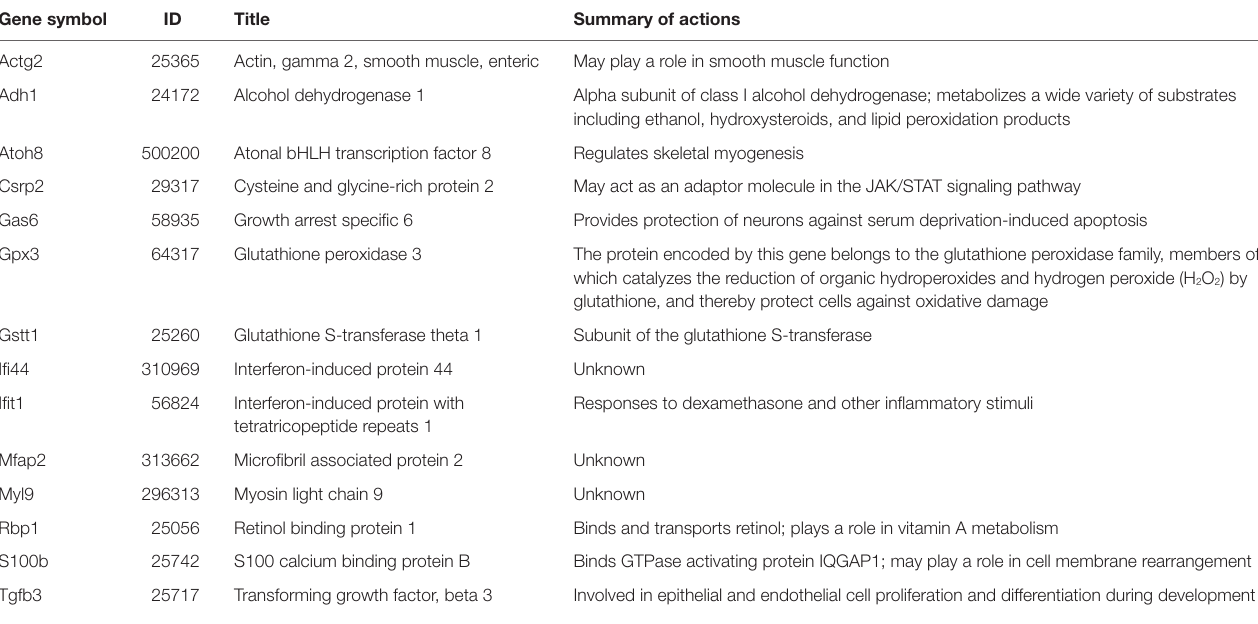
TaBle 2 | Actions of genes significantly regulated by RvE1